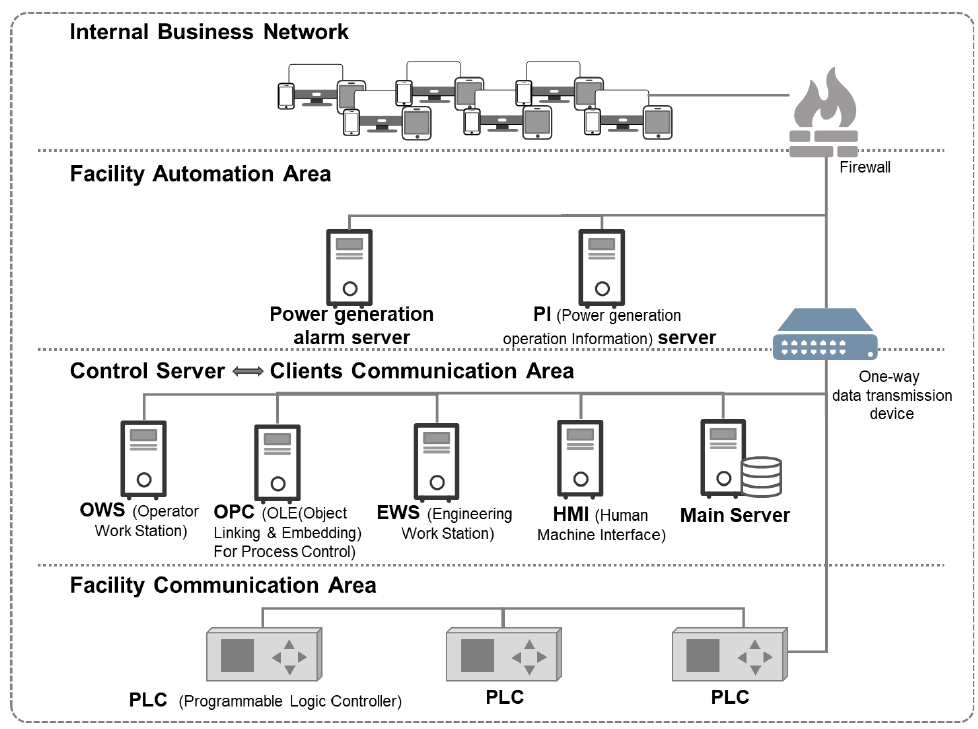
Figure 1. Network configuration of the power generation control system.